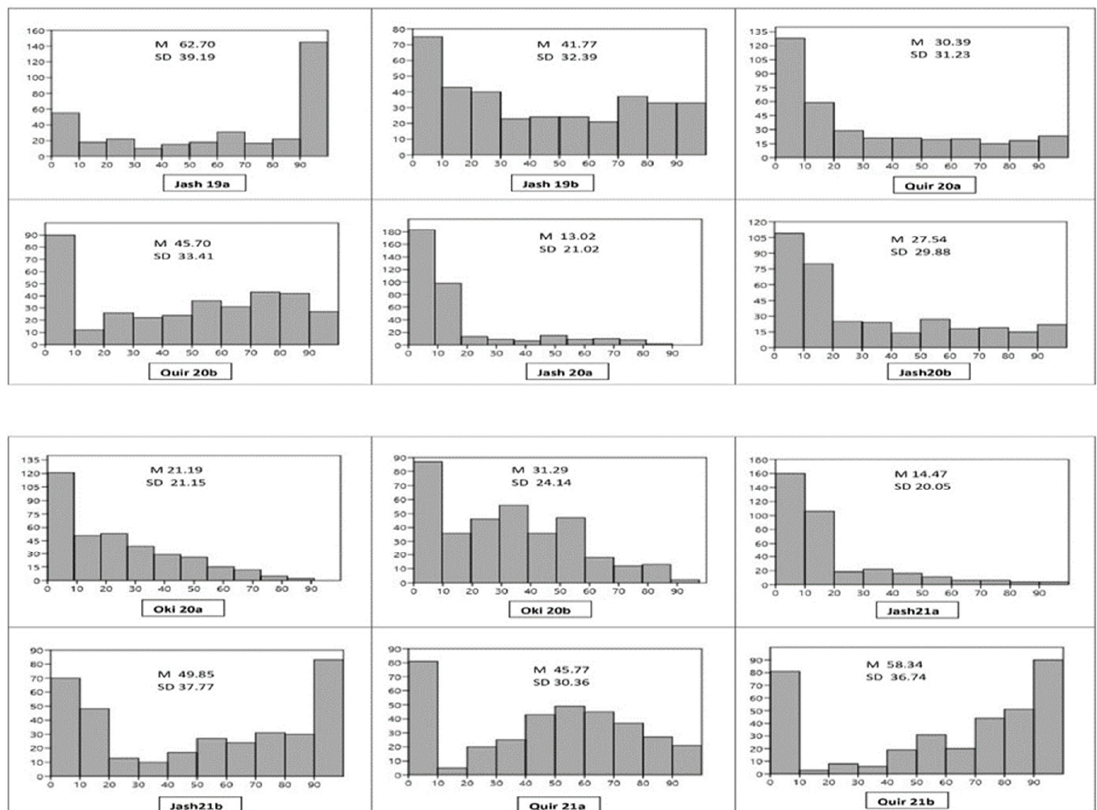
Figure 1. Histogram of wheat blast index (X axis) and number of genotypes (Y axis) in 12 individual experiments. M (Grand mean), SD (Standard deviation), Jash (Jashore), Quir (Quirusillas), Oki (Oki- nawa), 19 (2018–2019 cycle), 20 (2019–2020 or 2020 cycle), 21 (2020–2021), a (first sowing), b (second sowing). Table 1. Analysis of variance for wheat blast index in three locations and the corresponding herita- bility estimates.